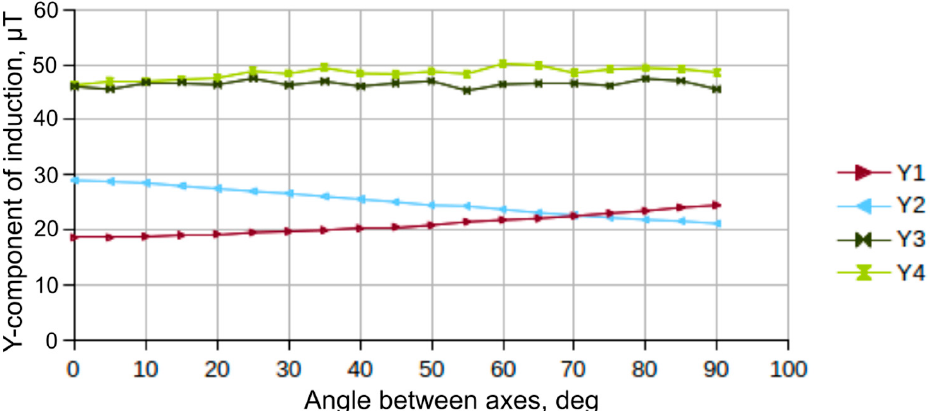
Figure 4. Dependence of the magnetic induction vector component along the Y-axis in the cores of ferromagnetic probes ("Y1"–"Y4" curves correspond to "D1"–"D4" elements).